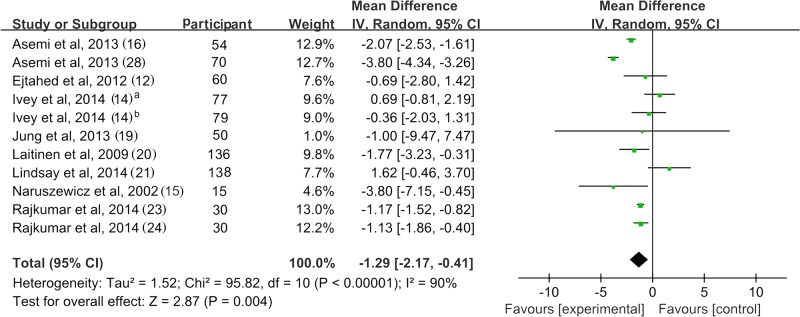
Forest plot of randomized controlled trials comparing the effect of probiotics on fasting plasma insulin with placebo/comparator.Weighted mean differences (95% CIs) for fasting plasma insulin are shown. Pooled estimates (diamonds) calculated by the random effects method. IV, inverse variance.